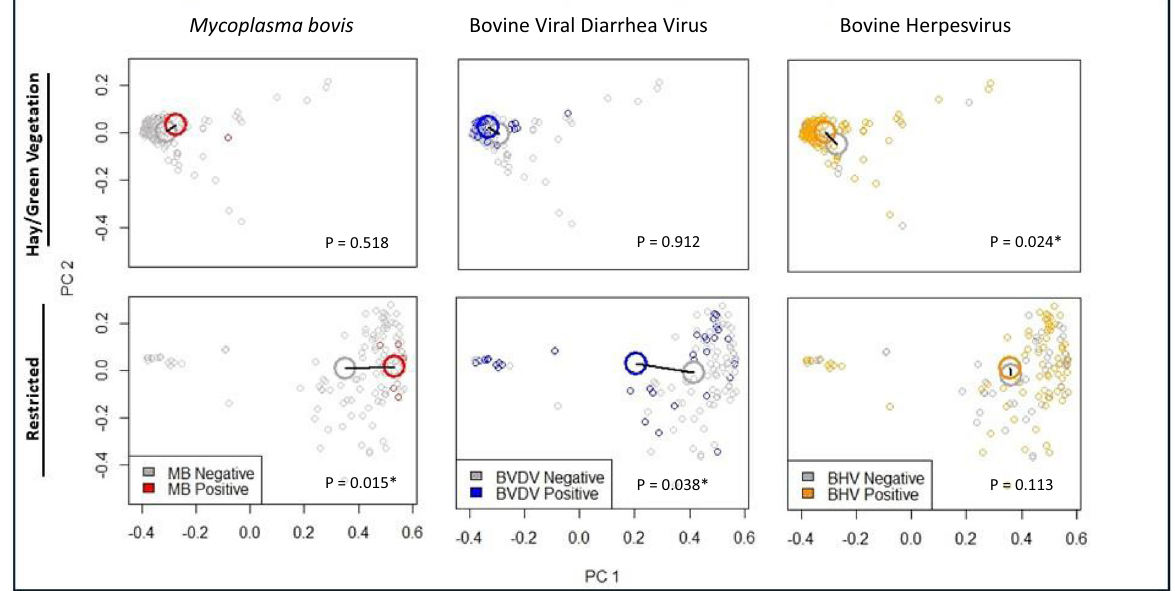
Fig. 3 Three respiratory infections associated with gut microbiome composition in African buffalo based on canonical correspondence analysis: Mycoplasma bovis (MB), bovine viral diarrhea virus (BVDV), and bovine herpesvirus (BHV). Differences in the magnitude and/or direction of association between disease and the microbiome were observed between the restricted regime and the hay/green vegetation regime based on visualization and env fi t analysis of principal coordinate analysis. This plot shows differences in microbiome community composition associated with infection status based on principal coordinate analysis of Bray – Curtis distances for the restricted and hay/green vegetation regimes. Analysis by env fi t was based on 134 samples in the restricted regime (5 MB positive, 35 BVDV positive, 85 BHV positive) and 177 samples in the hay/green vegetation regime (10 MB positive, 48 BVDV positive, 159 BHV positive) for which complete disease datasets were available. p -values for env fi t analysis of infections within each group are shown on each panel. Colored points indicate seroconversion ( M. bovis , positive = red) or presence (BVDV, positive = blue; BHV, positive = yellow), and gray points indicate lack of seroconversion ( M. bovis ) or absence (BVDV and BHV). Small points indicate individual samples, and larger circles indicate the means for infected and uninfected groups. Source data are provided as a Source Data fi